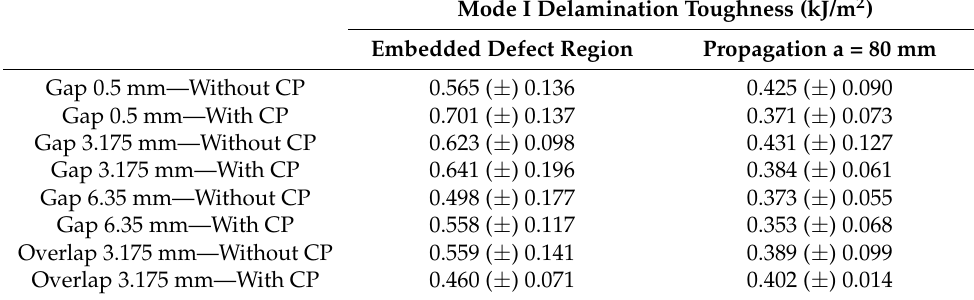
Table 1. Summary of Mode I test results. Mean values and standard deviations from tests on 6 specimens for each